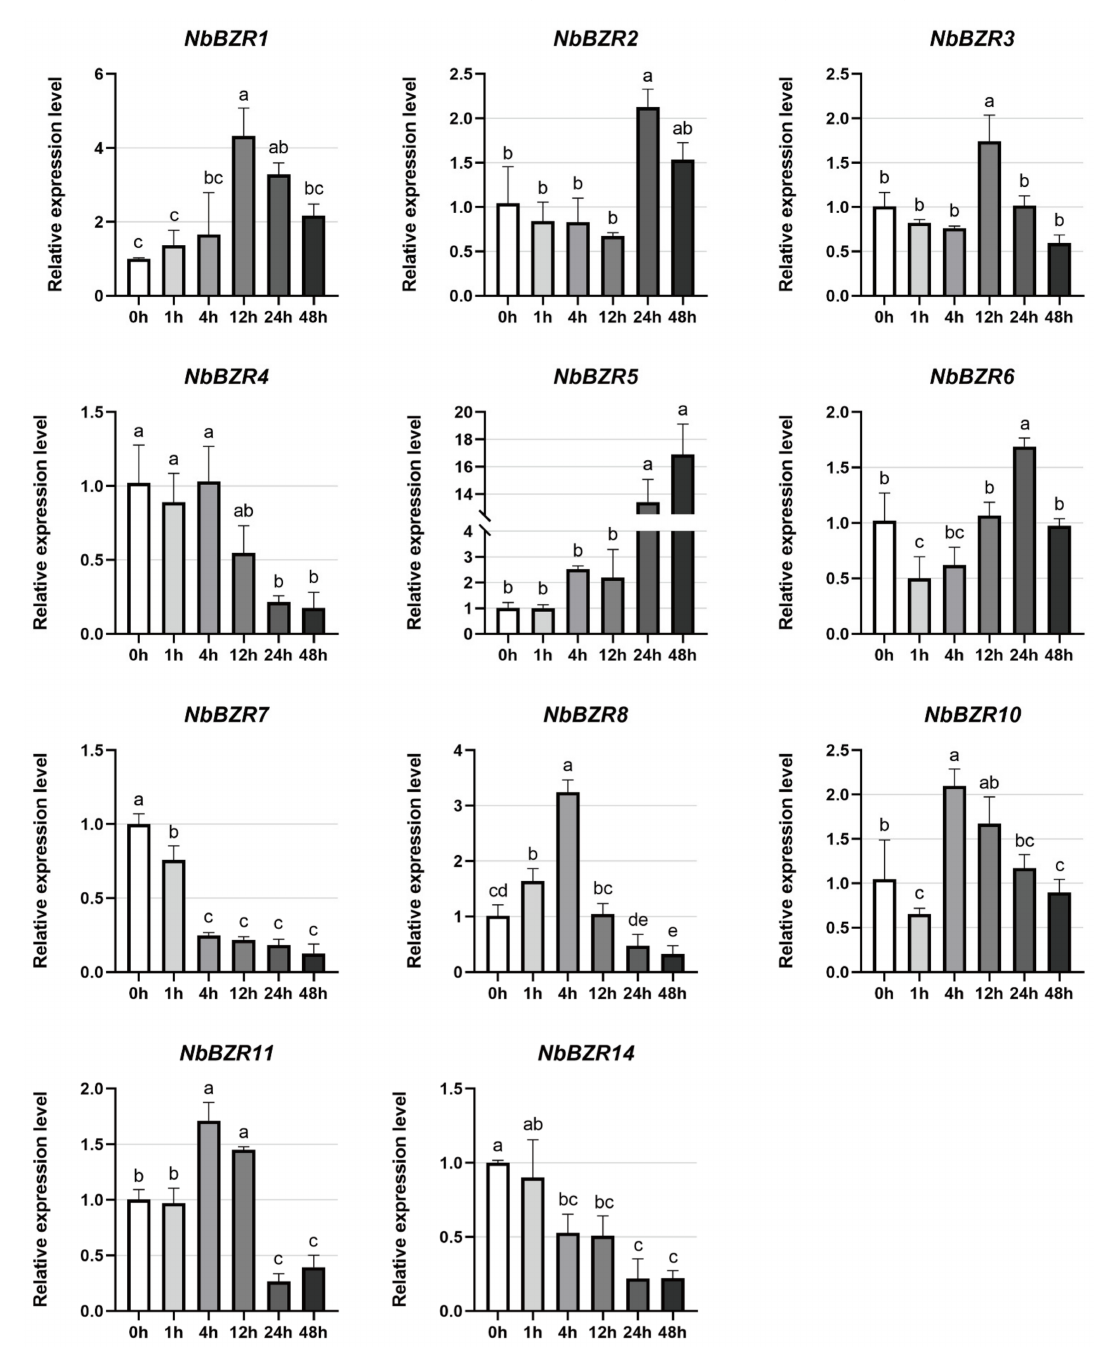
Figure 6. Expression analysis of NbBZRs after cold treatment (0–48 h). Gene expression was normalized to control unstressed expression level, which was assigned a value of 1. Data represent averages of three independent experiments ± SD. Standard errors are shown as bars above columns. Different letters indicate significant differences according to Tukey’s multiple comparisons test. Columns with different marked letters are significantly different ( p < 0.05), and those with the same marked letter or share a letter are not significantly